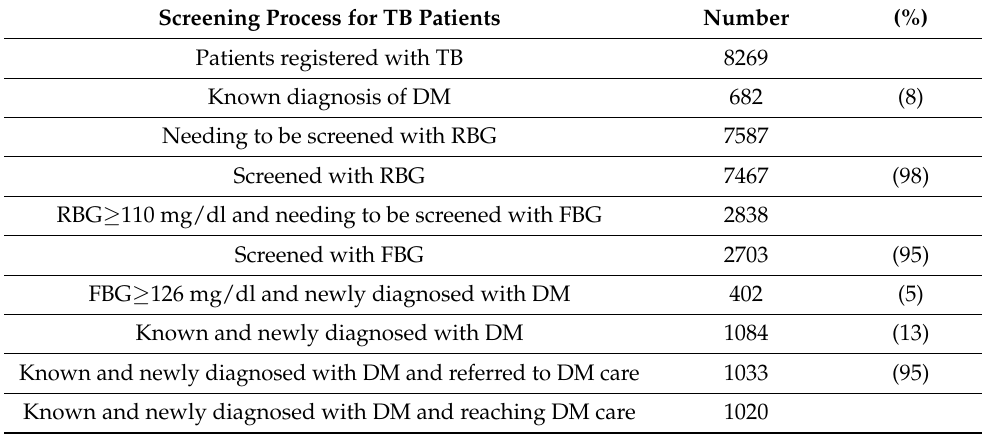
Table 3. Screening of TB patients for Diabetes Mellitus in selected health facilities in India. Screening Process for TB